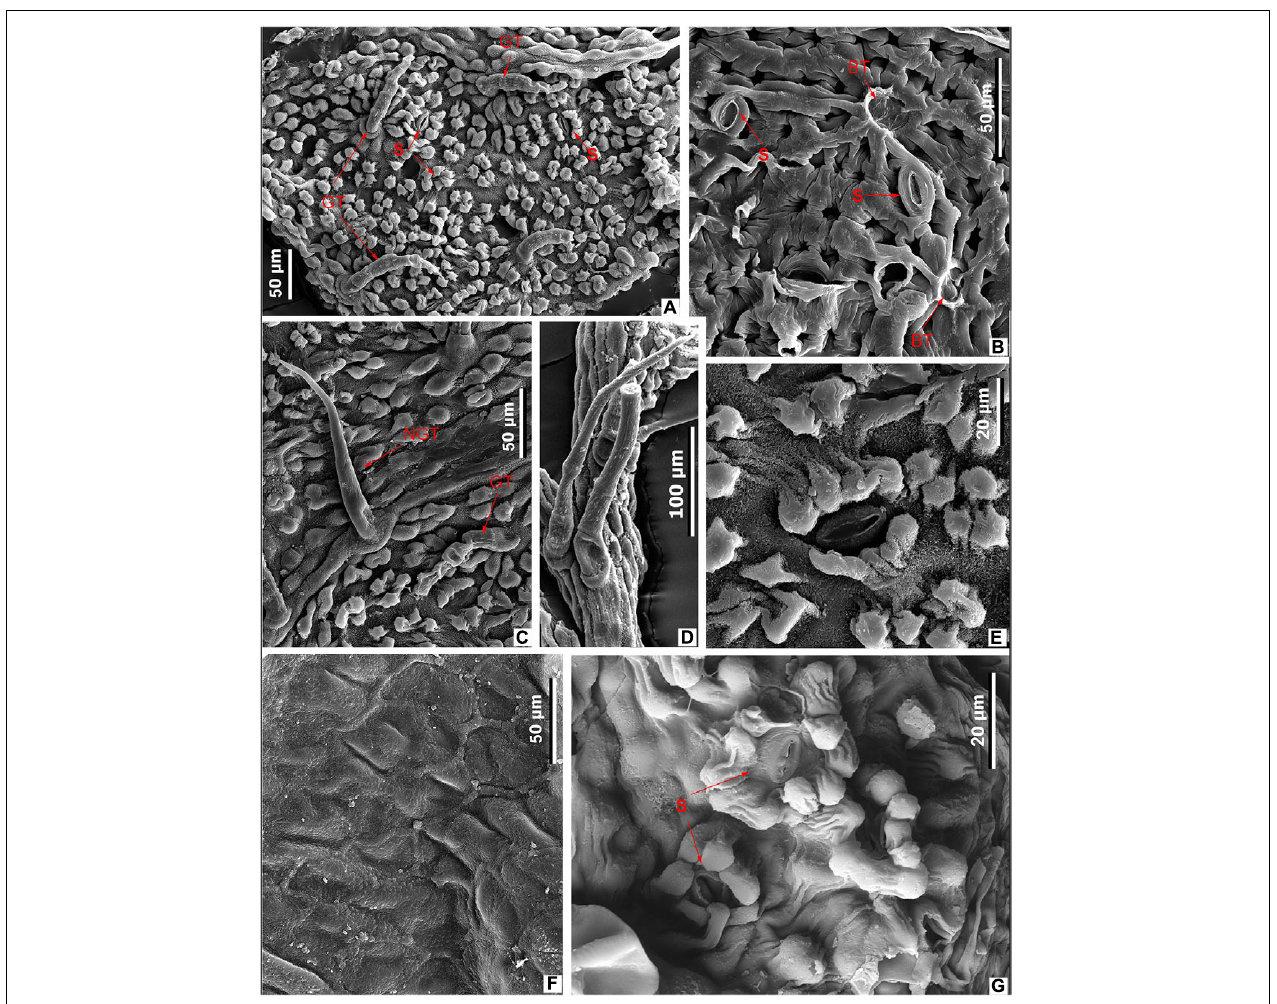
FIGURE 12 | Leaf epidermal characters of extant Meliosma , SEM. M. fordii Hemsl., SYS00085139 (A–F) . (A) Abaxial surface with papillate cells, stomata (S), and glandular trichomes (GT), external view. (B) Abaxial surface with stomata (S) and trichome base (BT), internal view. (C) Abaxial surface with glandular (GT) and unicellular non-glandular (NGT) trichomes, external view. (D) Multicellular non-glandular trichomes. (E) Stomata surrounded by papillae, external view. (F) Ordinary cells on adaxial surface, internal view. (G) M. rigida Siebold et Zucc., SYS00085214, stomata (S) with papillae on abaxial surface, external